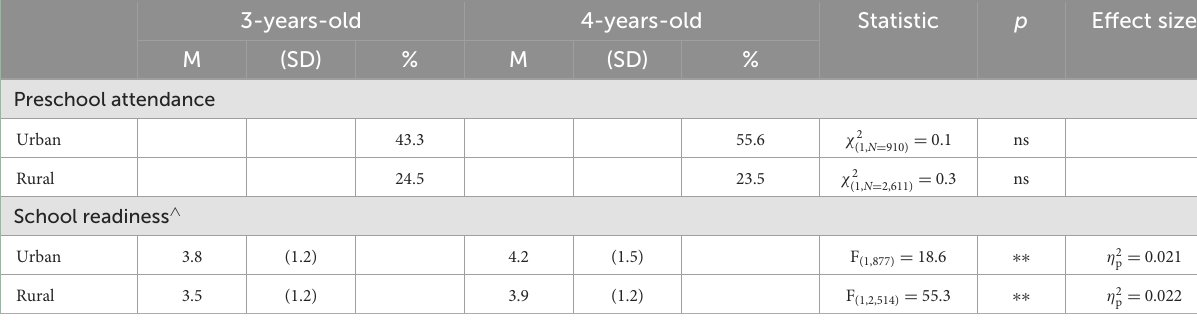
TABLE 5 Differences in preschool attendance and school readiness scores between 3- and 4-year-old children in Côte d’Ivoire.